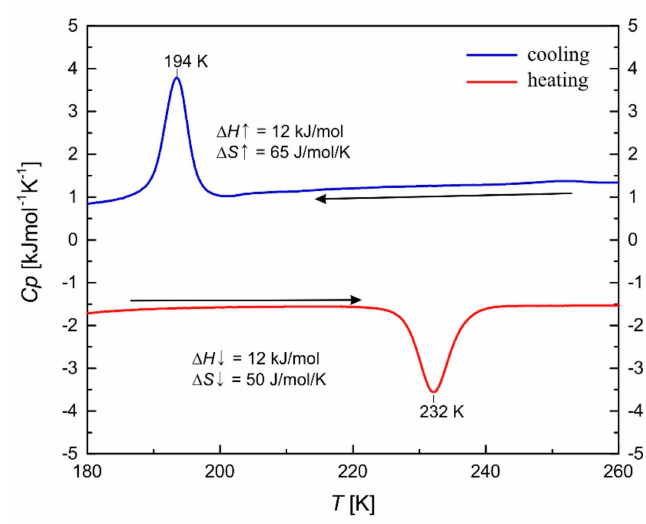
Figure 5. Di ff erential scanning calorimetry (DSC) measurement of 3a . Measured enthalpy and entropy values are given in the cooling (blue line) and heating (red line) modes (5 K /